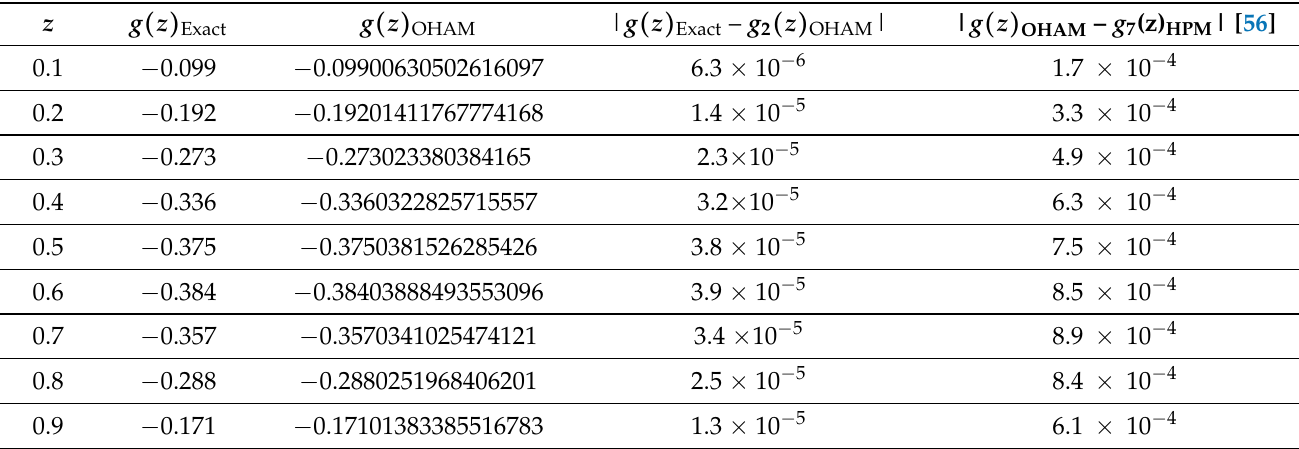
Table 2. Absolute error comparison of exact solutions with 2nd order OHAM solutions of g ( z ) and 7th order solutions of HPM.